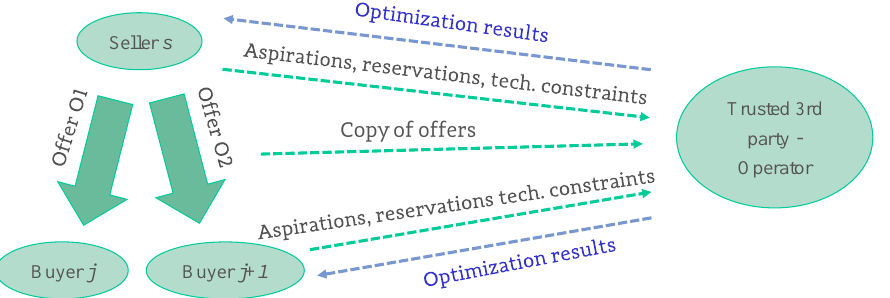
Figure 1. Schema of proposed balancing